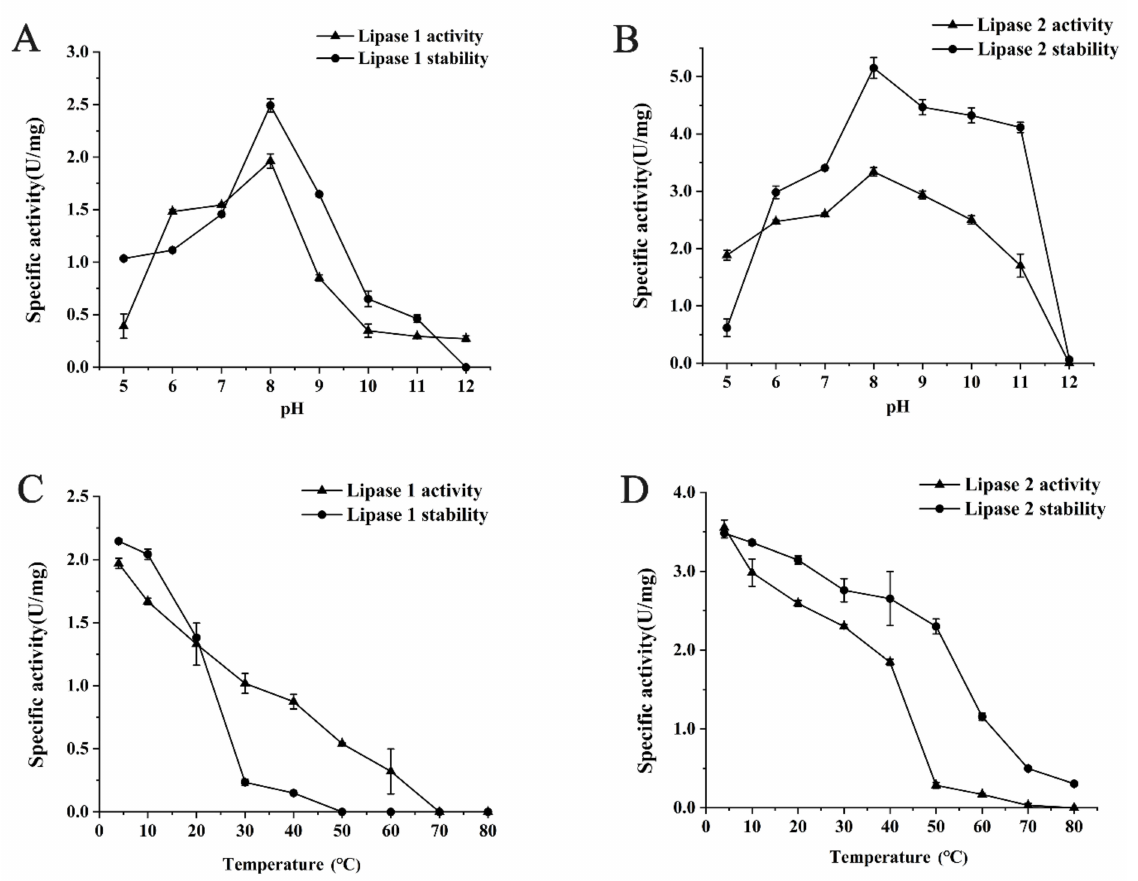
Figure 3. Effects of pH and temperature on the activity and stability of lipases. Effects of pH on the activity and stability of Lipase 1 ( A ) and Lipase 2 ( B ). Effects of temperature on the activity and stability of Lipase 1 ( C ) and Lipase 2 ( D